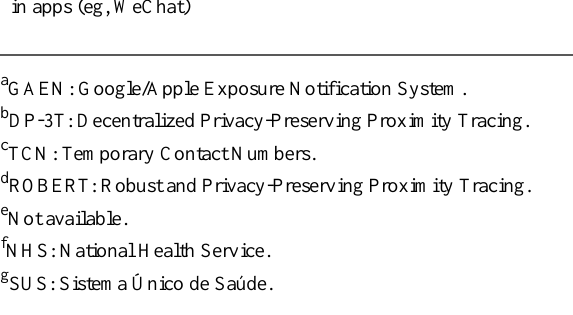
metadata—ChinaVarious integrated tracing